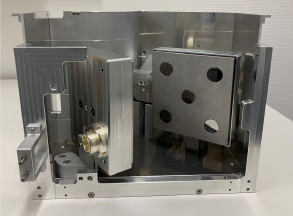
Figure 22. FM prototype with realistic WAVS geometry (scale 1:1). Reprinted from Ref. [123].